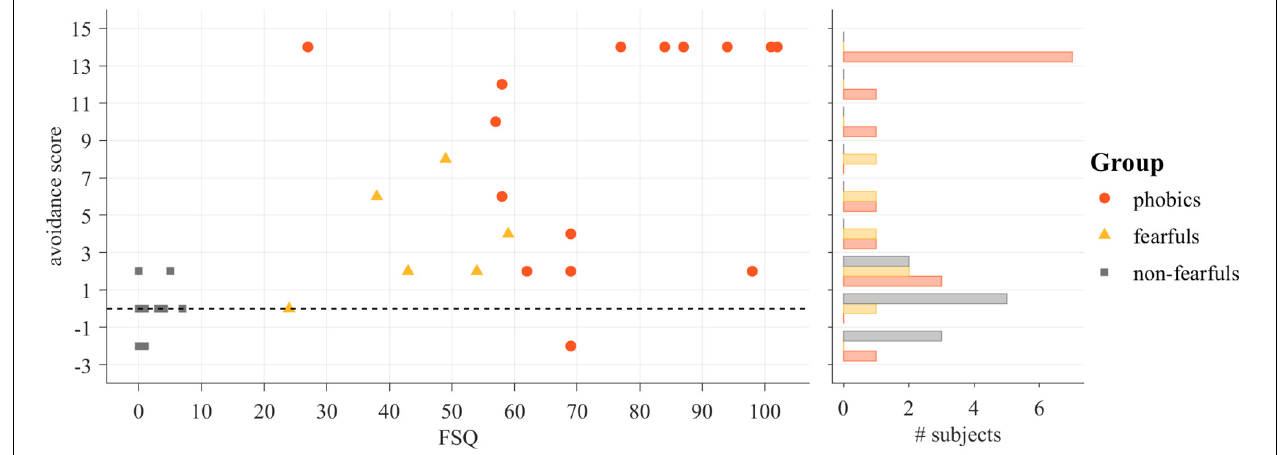
FIGURE 6 | The result of the Path-Choice task dependent on the Fear of Spiders Questionnaire (FSQ) score (left) and accumulated in a histogram (right).